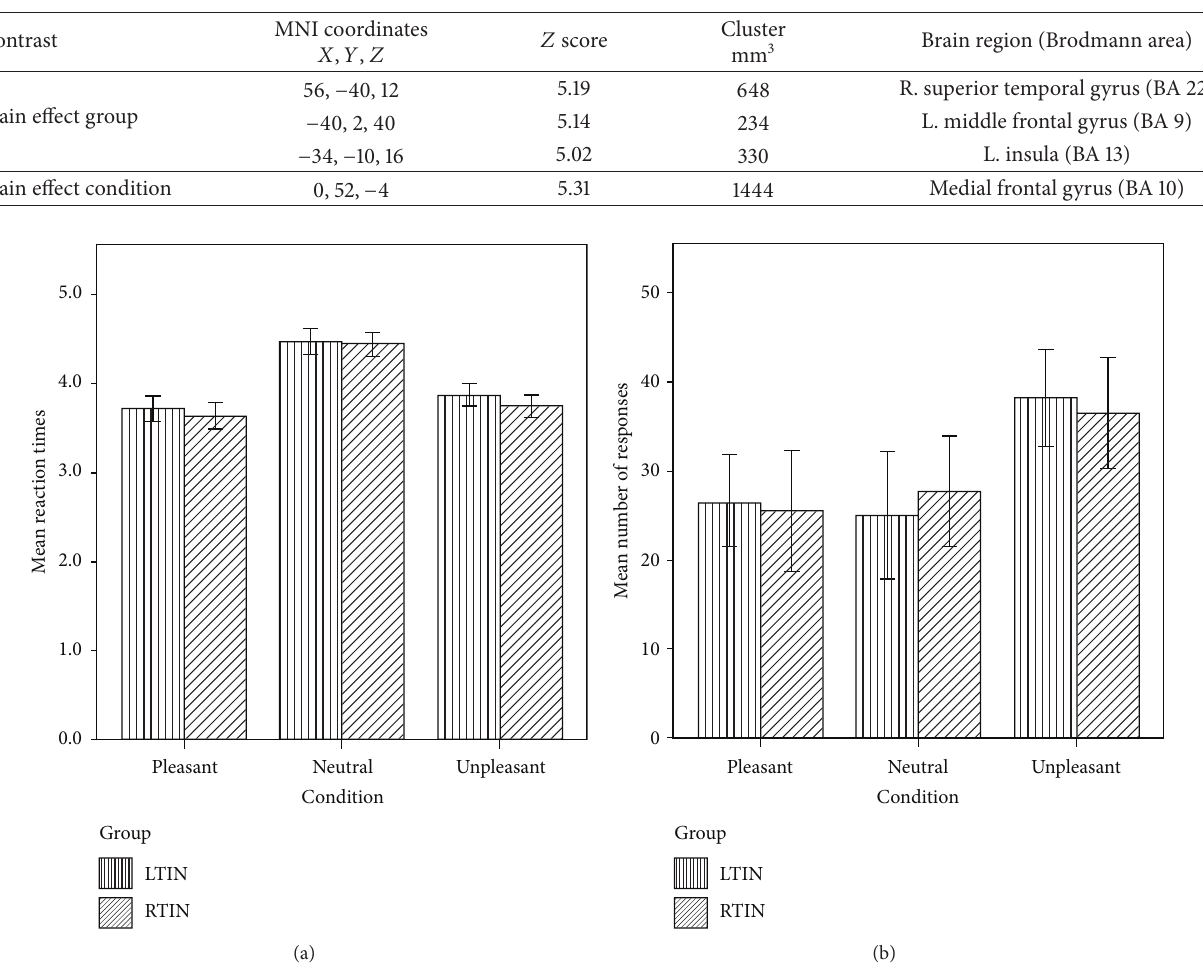
Figure 1: (a) Reaction time results for the emotion task. Both LTIN and RTIN groups responded slower to N sounds compared to P and U sounds. However, there were no significant differences observed between groups. (b) Behavioral response results for the emotion task. Both LTIN and RTIN groups responded more to U sounds than to P sounds. The LTIN group also responded to U sounds more than to N sounds. There were no significant differences observed between groups. Statistical significance 𝑝 < 0.05